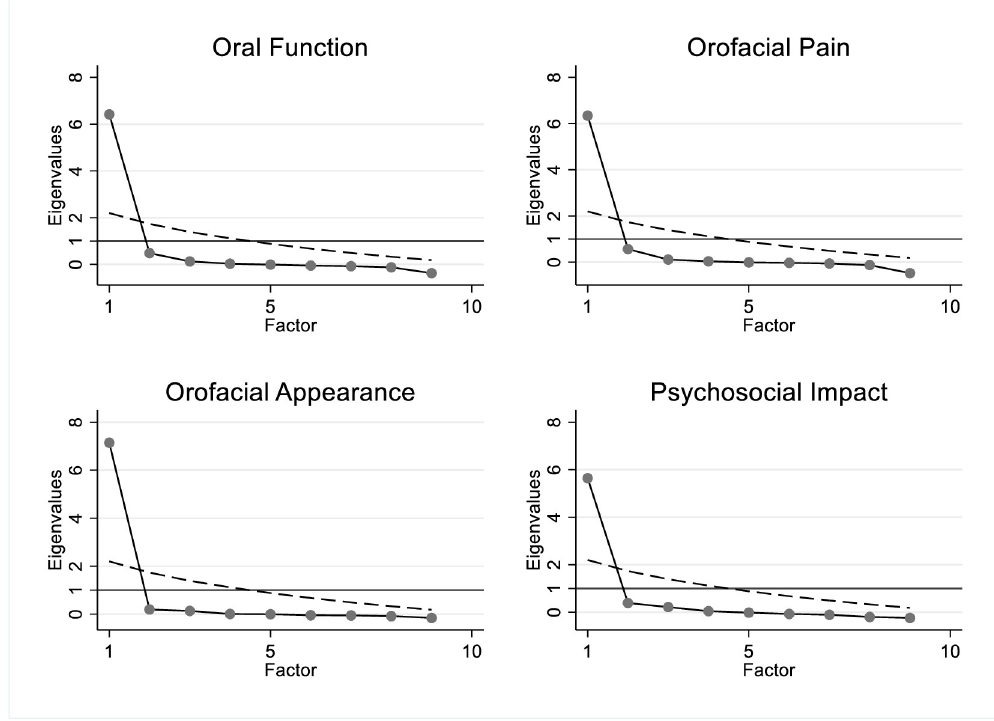
Fig 2. Horn’s parallel analysis to determine expert panelists’ responses dimensionality for the four OHRQoL dimensions.